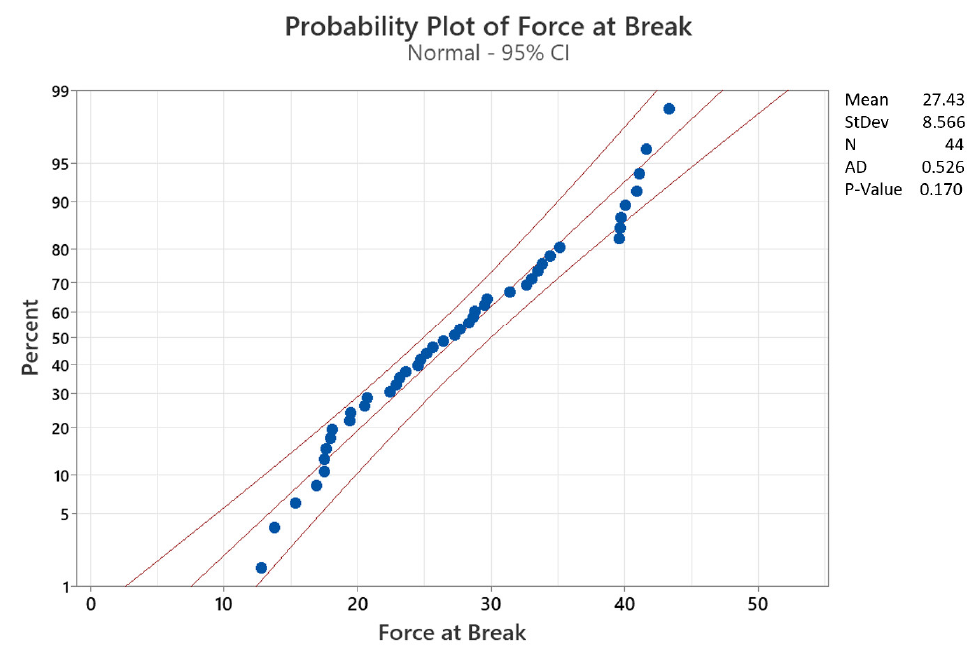
Figure 10. Normal distribution probability plot for force at break.